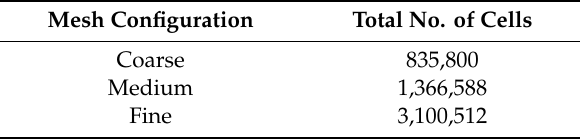
Table 2. Mesh numbers for each mesh configuration.